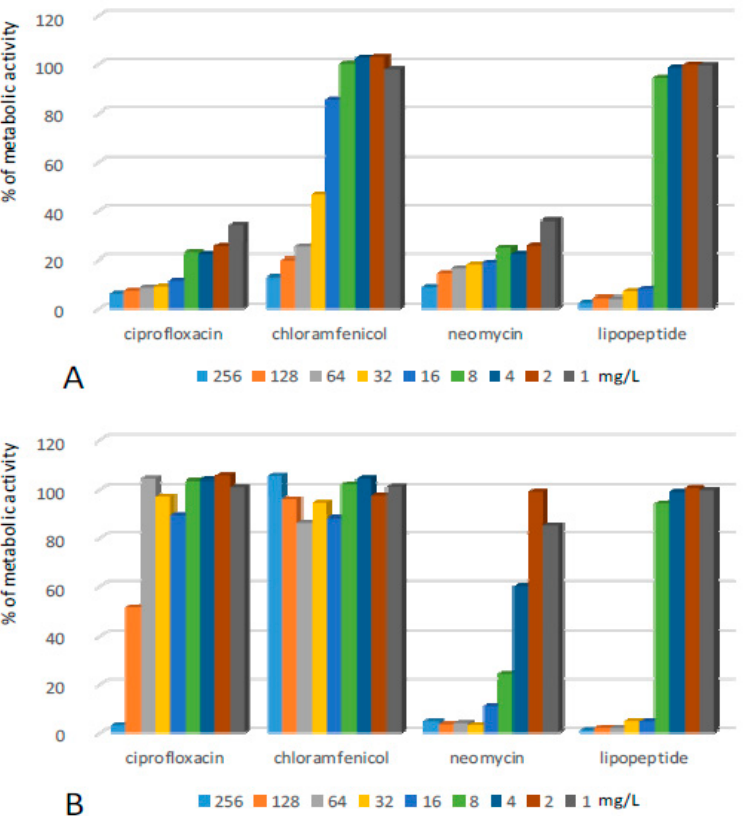
Figure 1. Activity of the lipopeptide and conventional antimicrobials applied at concentrations of 1–256 mg/L against SE biofilms formed on polystyrene ( A ) results read after 24 h exposure to compounds; and ( B ) results read after the withdrawal of compounds and an additional 24 h of incubation in MHB II. The results are presented as the percentage of metabolic activity in comparison to positive (100%) and negative (0%) controls; RSD ≤ 15%.